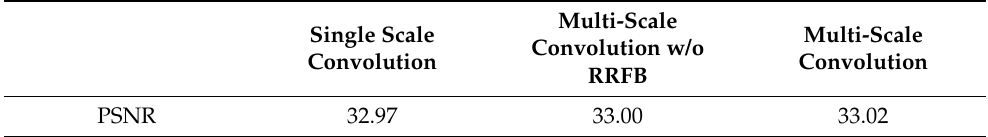
Table 1. Effects of different convolution units. We report the best average PSNR(dB) on Set14 (×2) in 2.5 × 10 4 iterations.